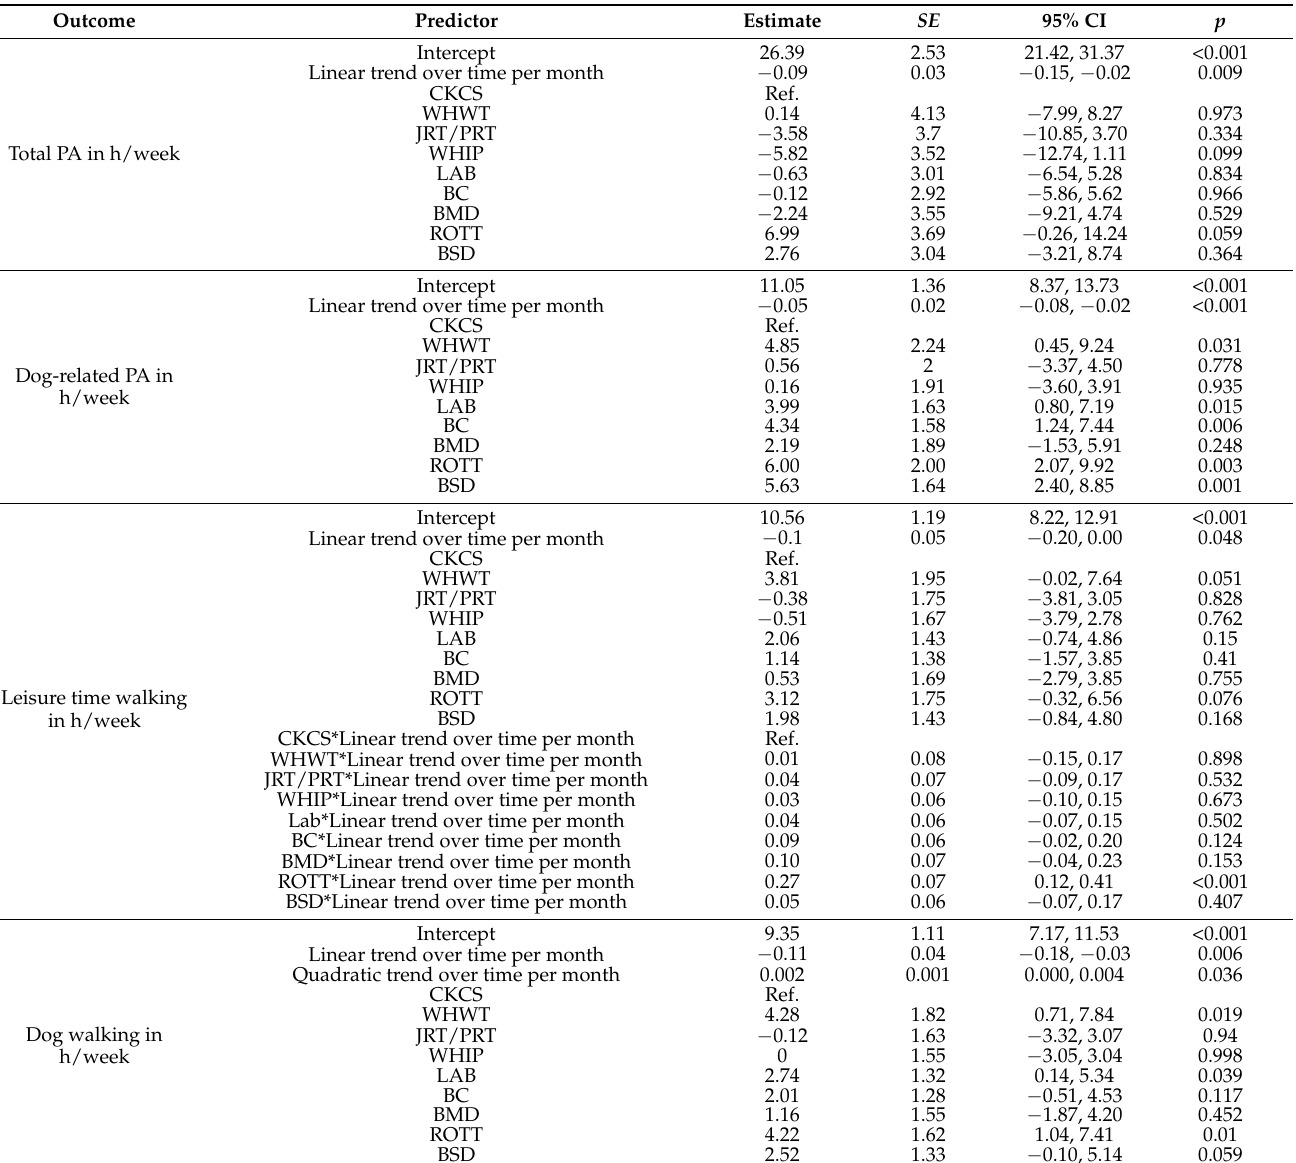
Table 4. Linear mixed models of total PA, dog-related PA, leisure time walking and dog walking over time in hours per